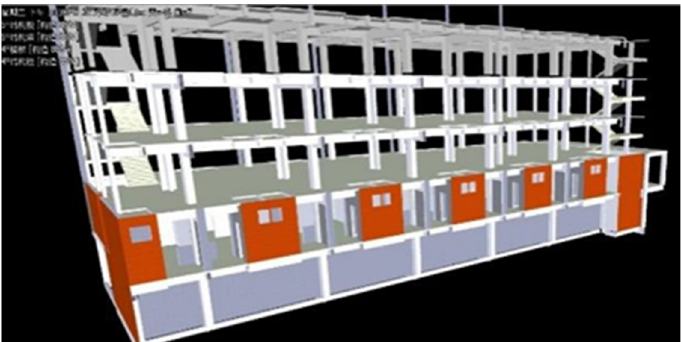
Figure 15. Project progress in week 7.